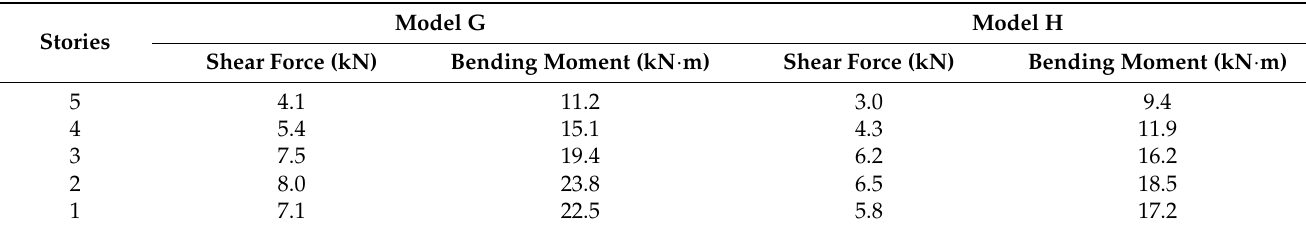
Table 19. A comparison of the internal force of the ladder beams.